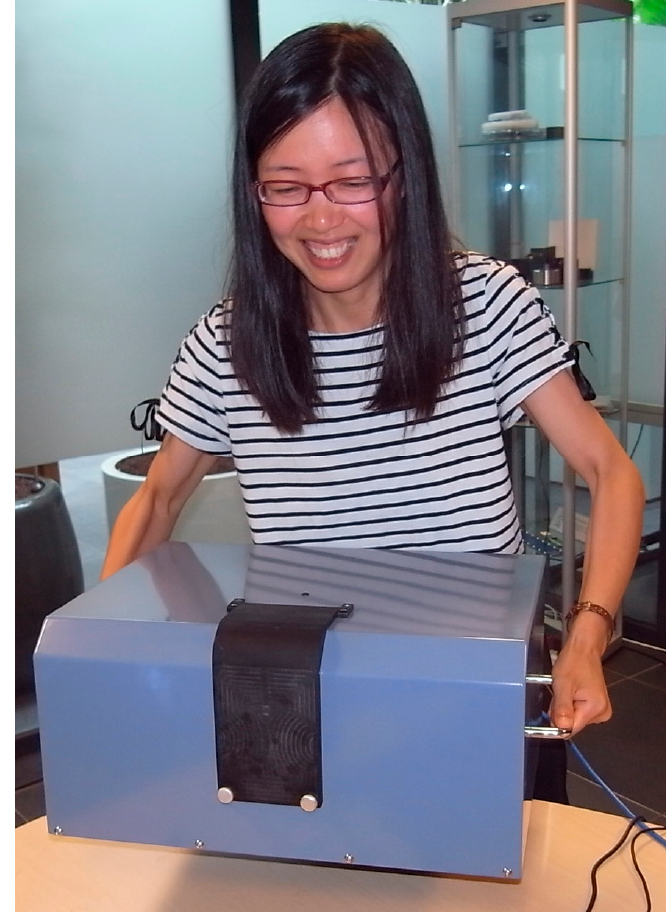
Figure 6. Portability test of FluoroTome 1.